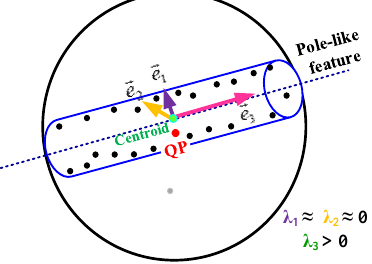
Figure 2. A local 3D neighbourhood representing a pole-like